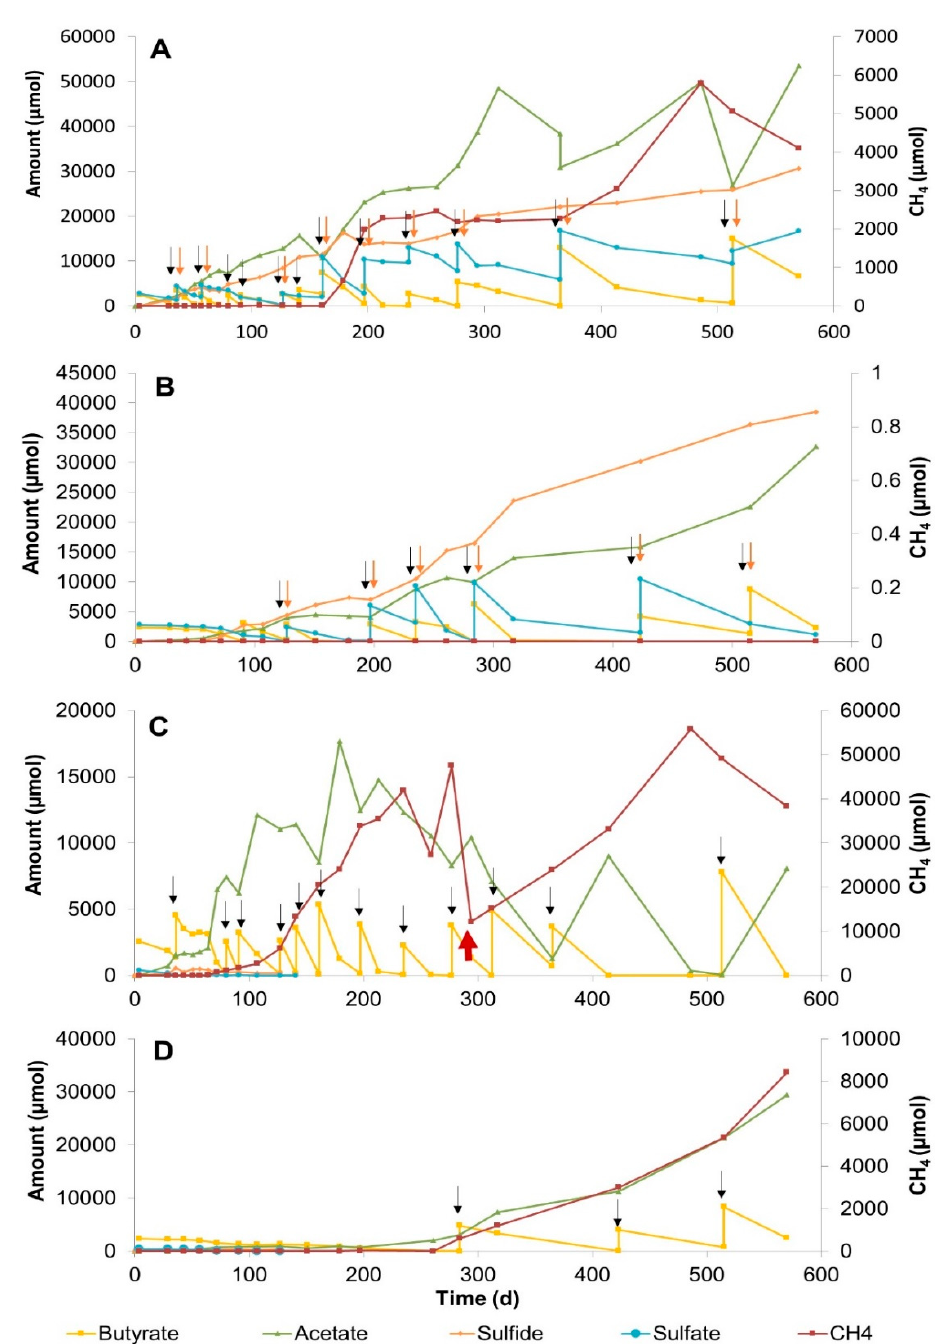
Figure 3. Changes in butyrate, sulfate, acetate, sulfide, and methane concentrations during 570 days of incubation in sediment slurry enrichments constituted of methane zone sediment. ( A ) Slurry MZB3, with 20 mM sulfate addition at 25 °C, ( B ) Slurry MZB2, with 20 mM sulfate addition at 10 °C, ( C ) Slurry MZB5, without sulfate addition at 25 °C. ( D ) Slurry MZB8, without sulfate addition at 10 °C. Arrows denote the time points for the additions of sulfate (red) and butyrate (black). The red arrow in Figure 3C indicates the time point that the excess amount of gas was exhausted from the headspace.